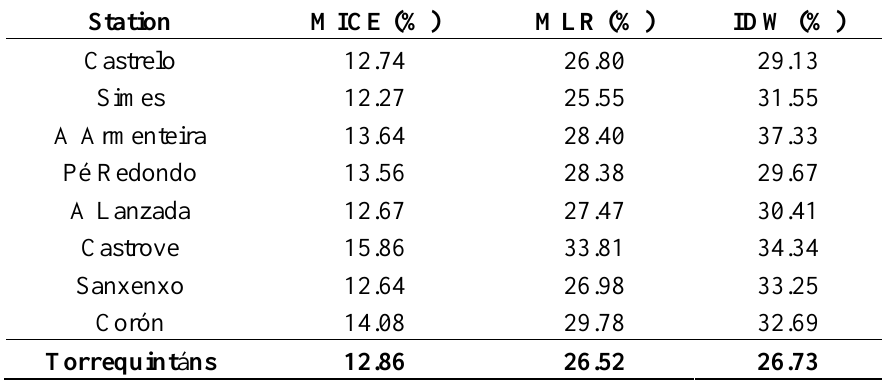
Table 9. Results of the three models in terms of RMSE.